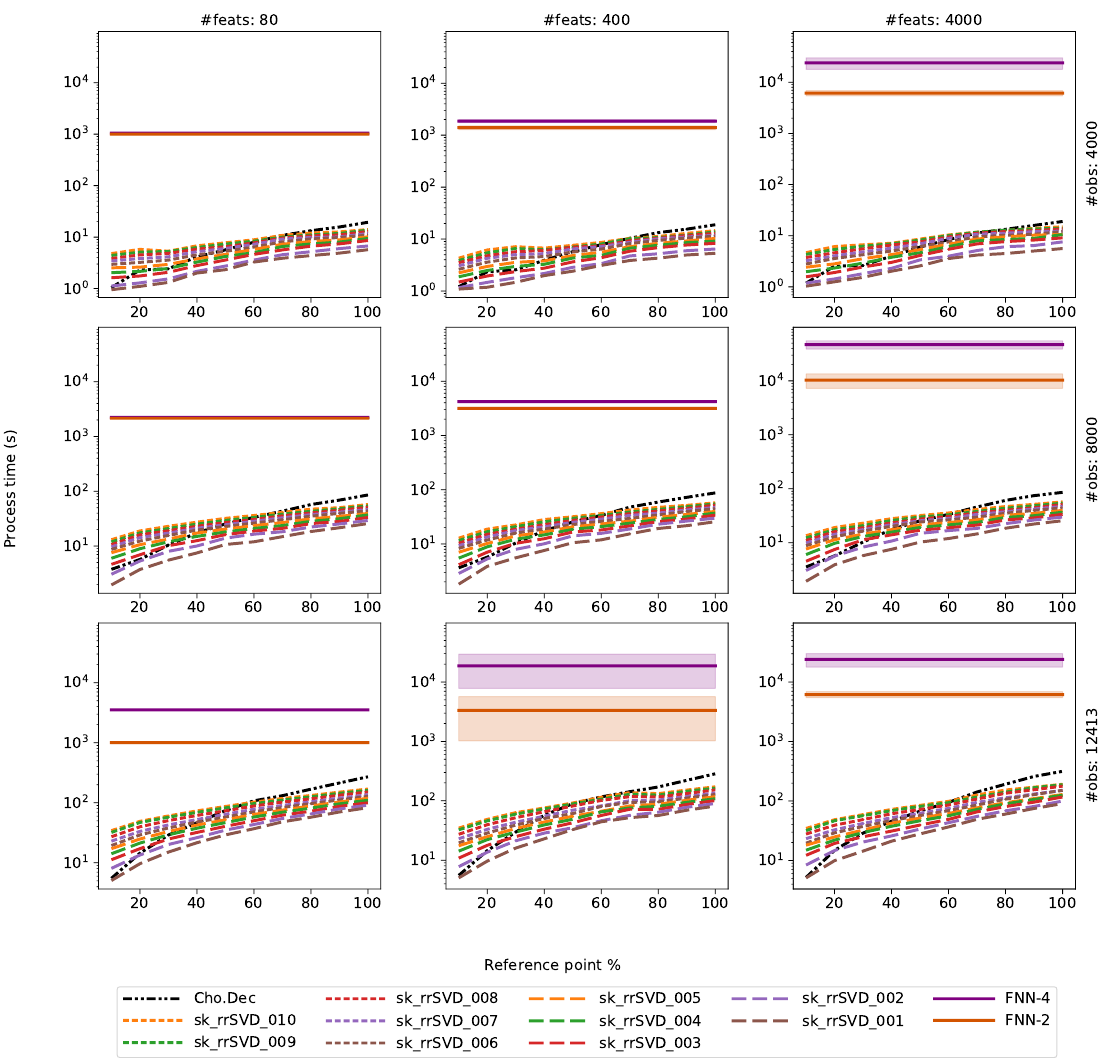
Figure A8. Process time for Au 38Q . Each subfigure has reference point percentage on the horizontal axis and normalized RMSE on the vertical axis. The top row corresponds to dataset variants with 4000 observations, middle row represents variants with 8000 observations and the bottom row is for the full dataset. The left column represents dataset variants with 80 features, middle represents 400 features and the right column is for the full feature set. Please note that the Y-axis is equalized in the